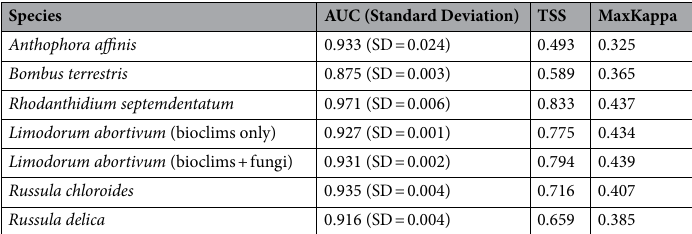
Table 2. Modelling performance